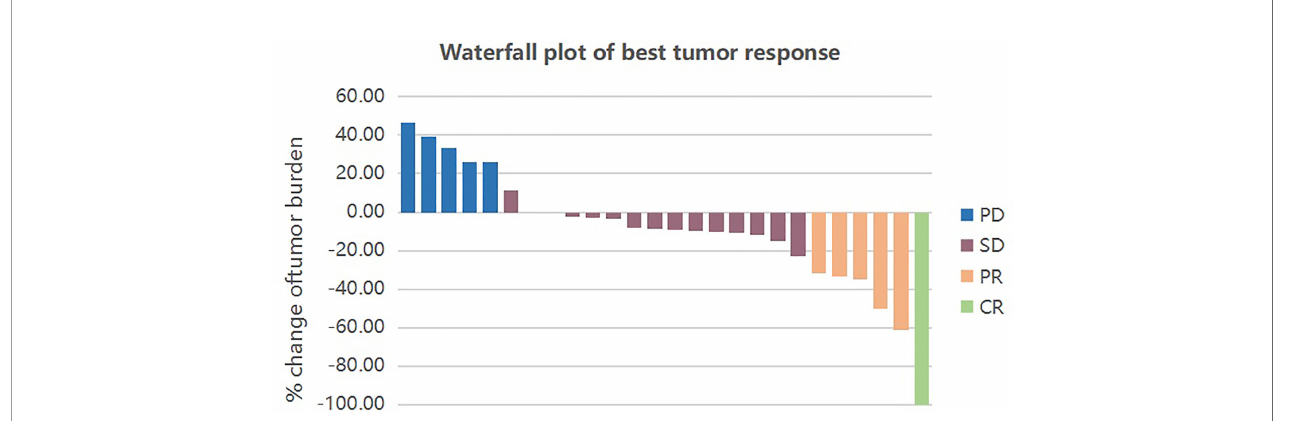
FIGURE 1 | Waterfall plot of best tumor response by RECIST1.1. Each bar represents the response of an individual patient. CR, complete response; PR, partial response; SD, stable disease; PD,